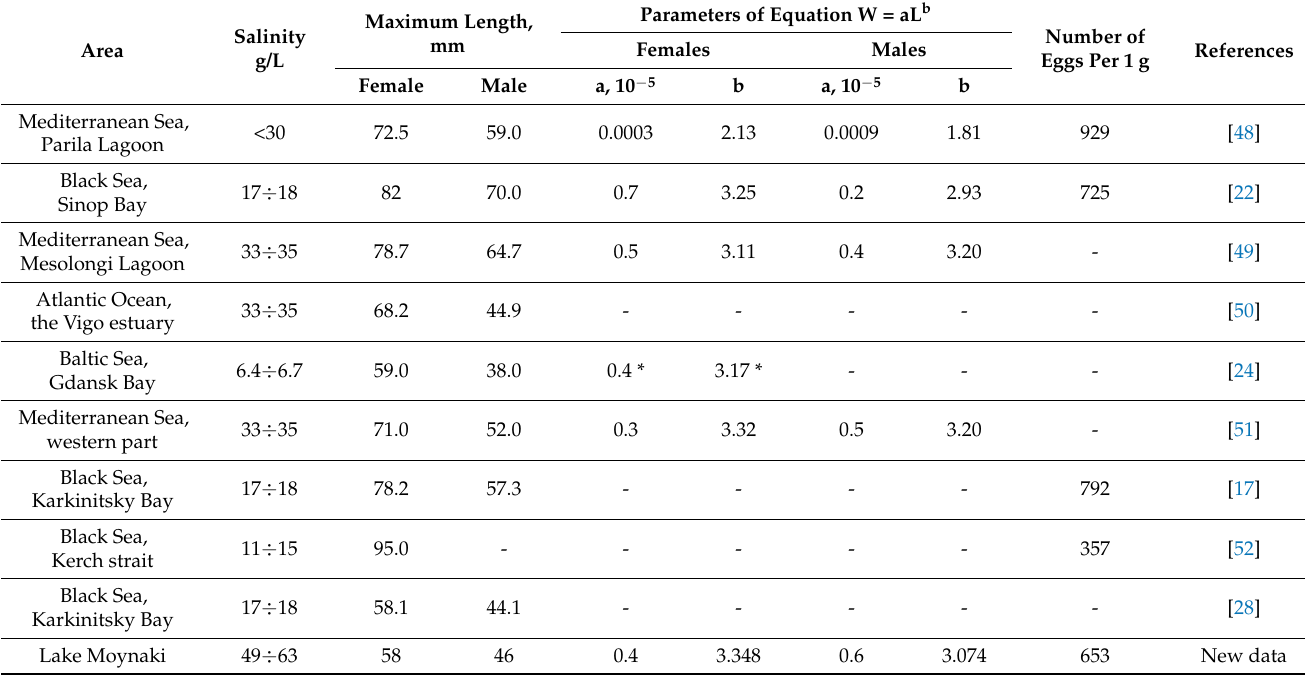
Table 1. Some quantitative characteristics of Palaemon adspersus in different parts of its